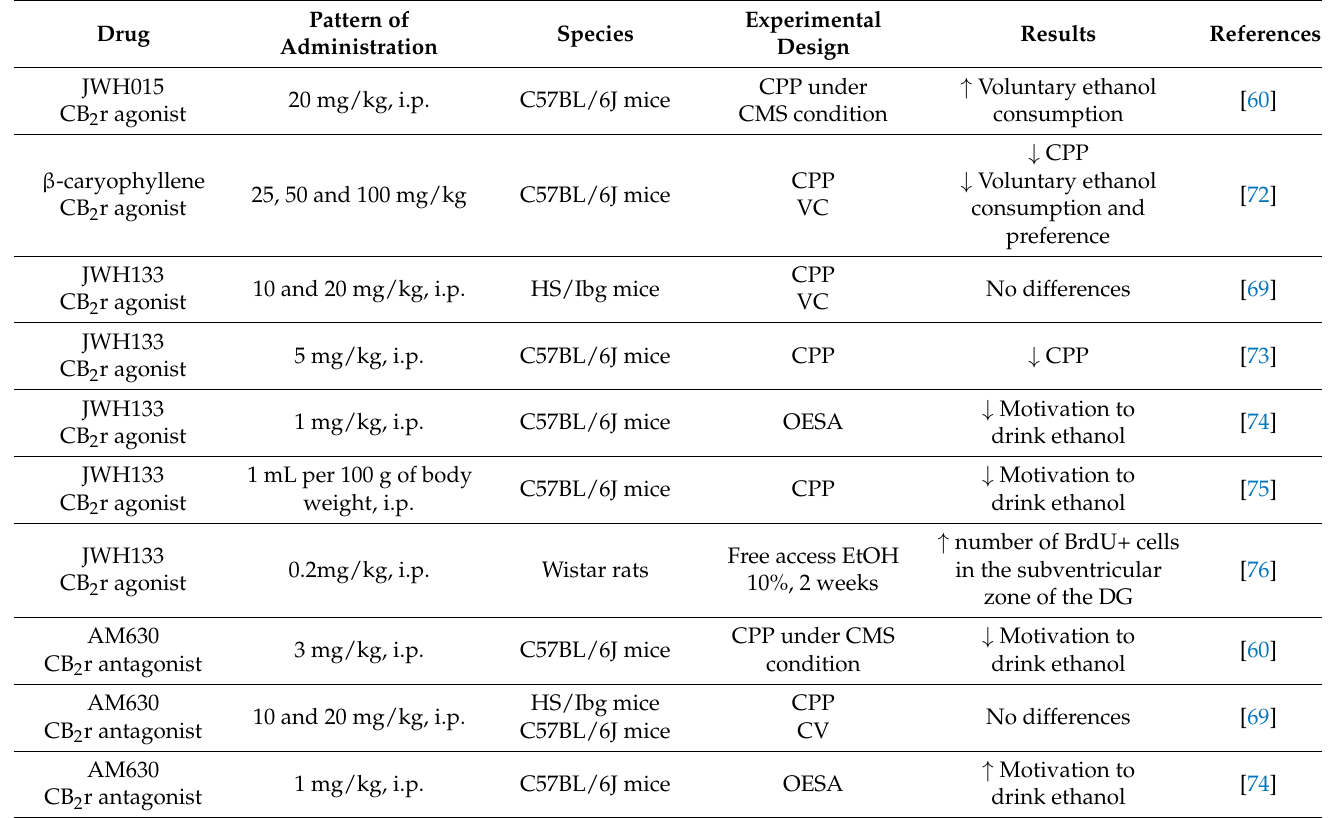
Table 3. Summary of the pharmacological studies in rodents studying the role of CB 2 r in animal models of alcohol